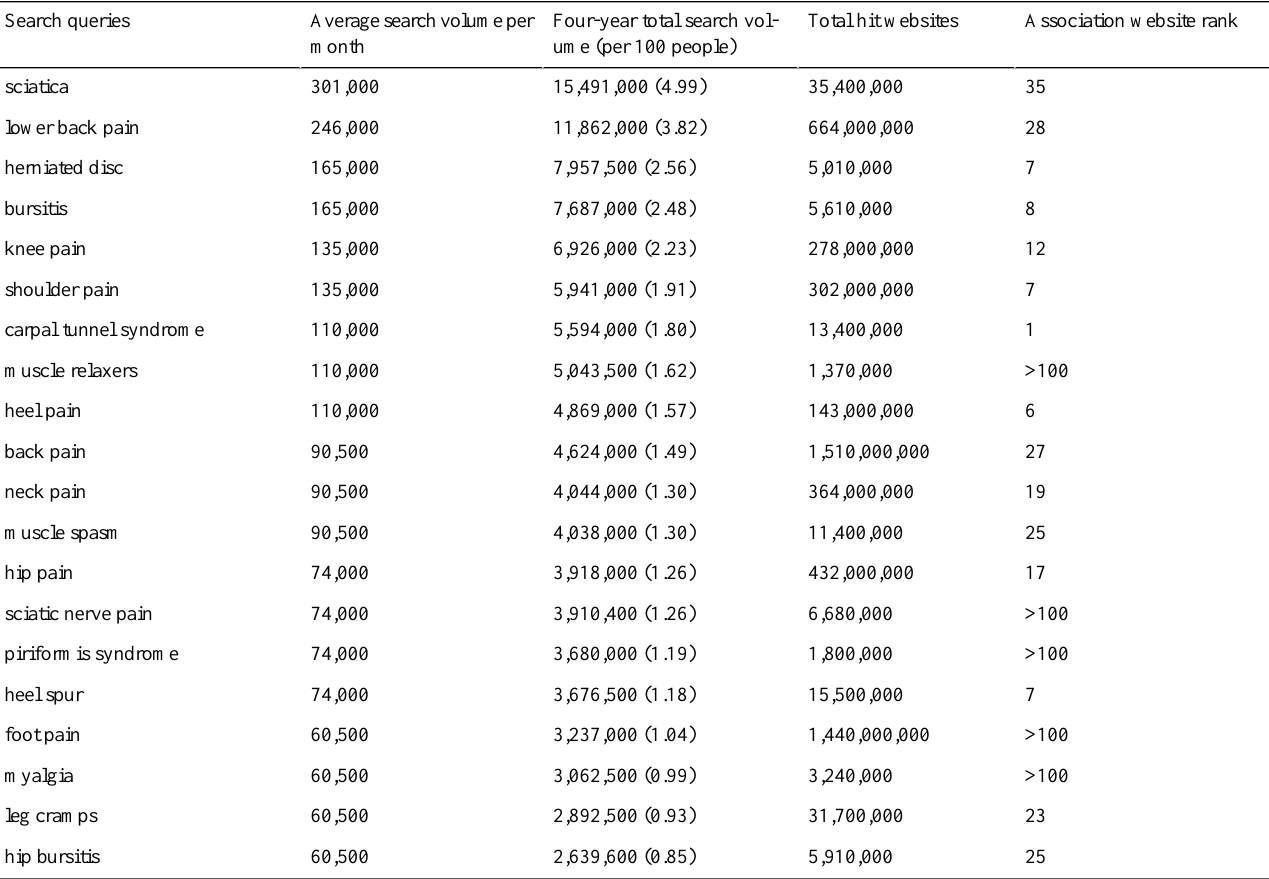
Table 1. Top 20 search queries in the United States.